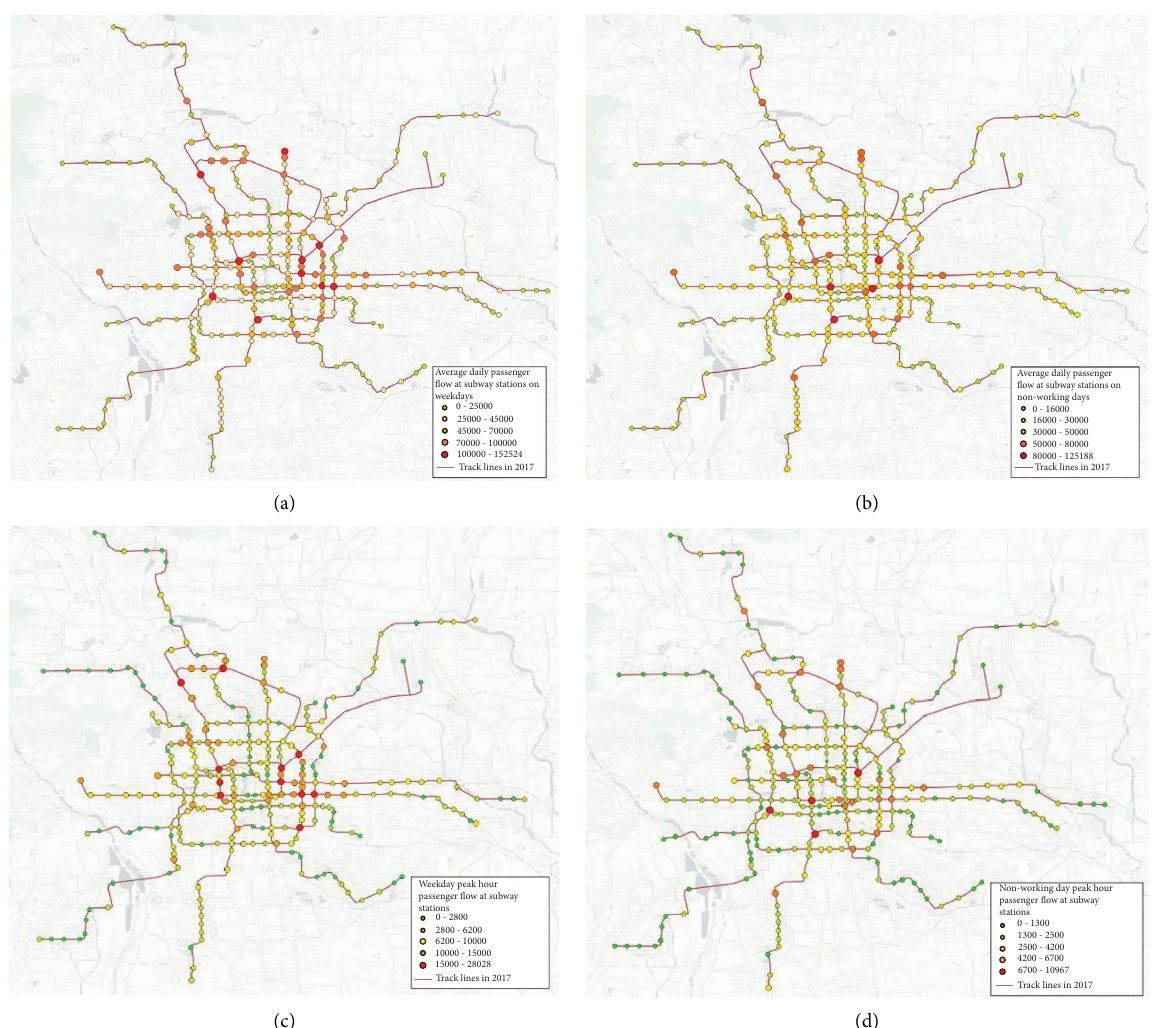
Figure 15: Passenger fow forecast target. (a) Average daily passenger fow at subway stations on weekdays; (b) average daily passenger fow at subway stations on nonworking days; (c) weekday peak hour passenger fow at subway stations; (d) nonworking day peak hour passenger fow at subway